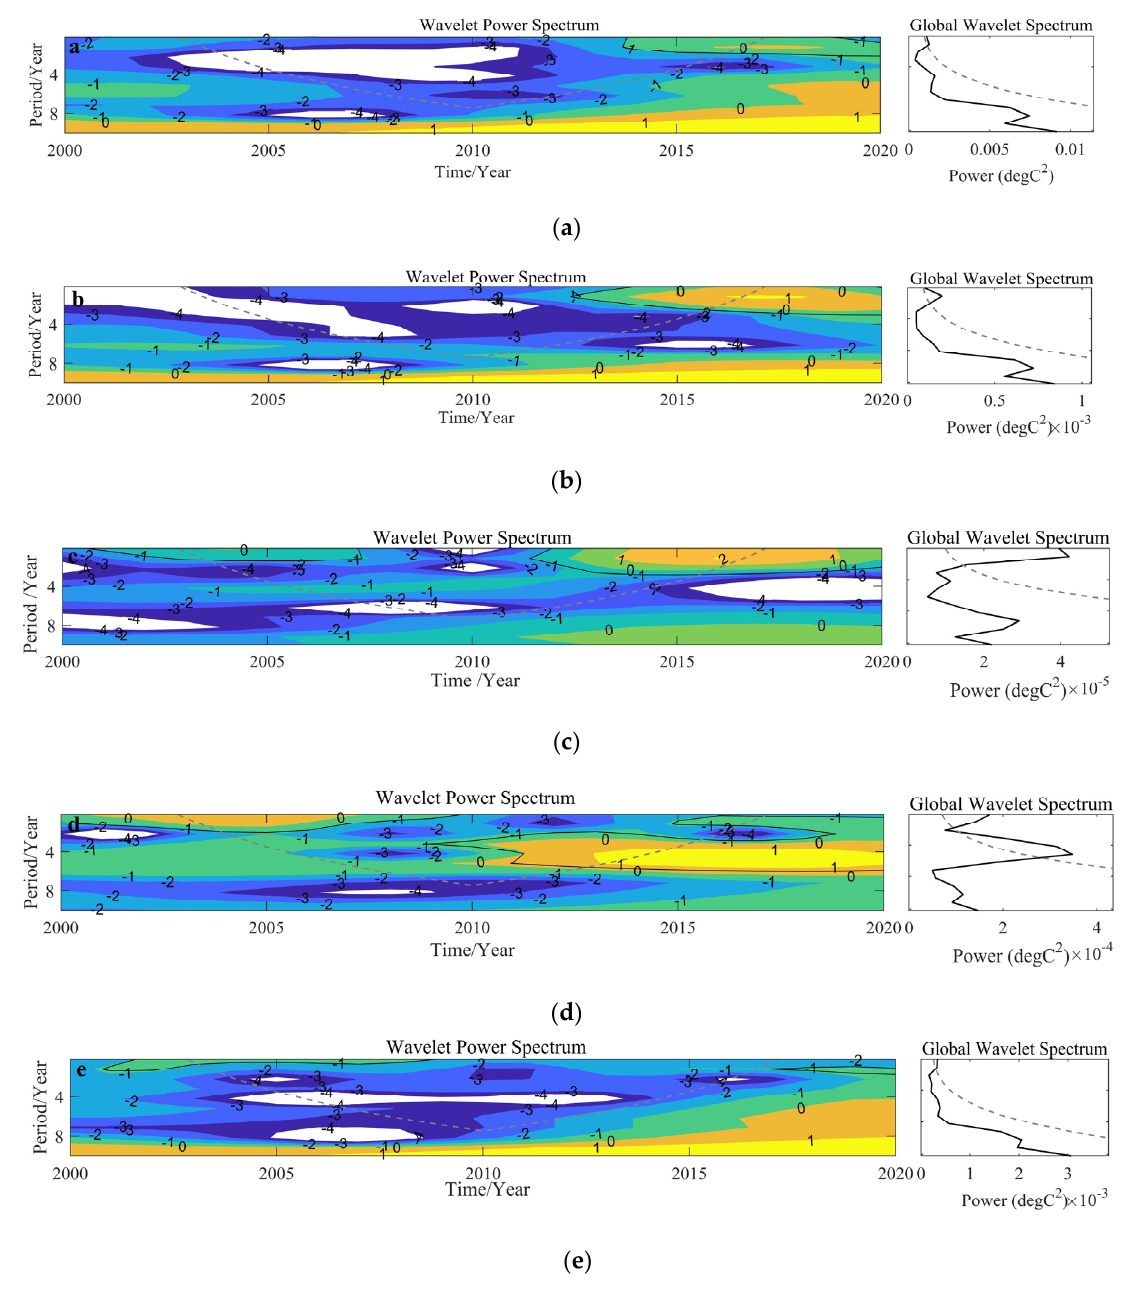
Figure 4. Wavelet spectrum analysis of SCF (2000–2020) on ( a ) annual, ( b ) spring, ( c ) summer, ( d ) autumn, and ( e ) winter scales.